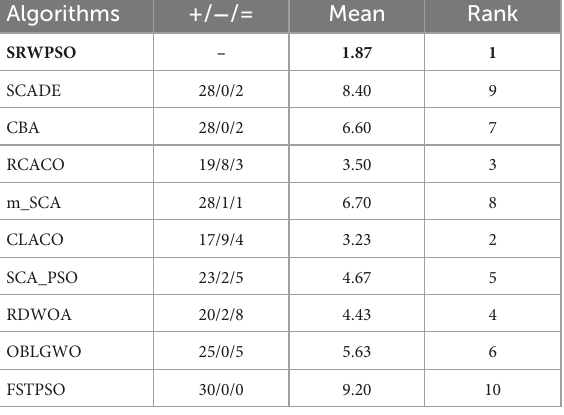
TABLE 8 The results of the Wilcoxon signed-rank test of SRWPSO with famous